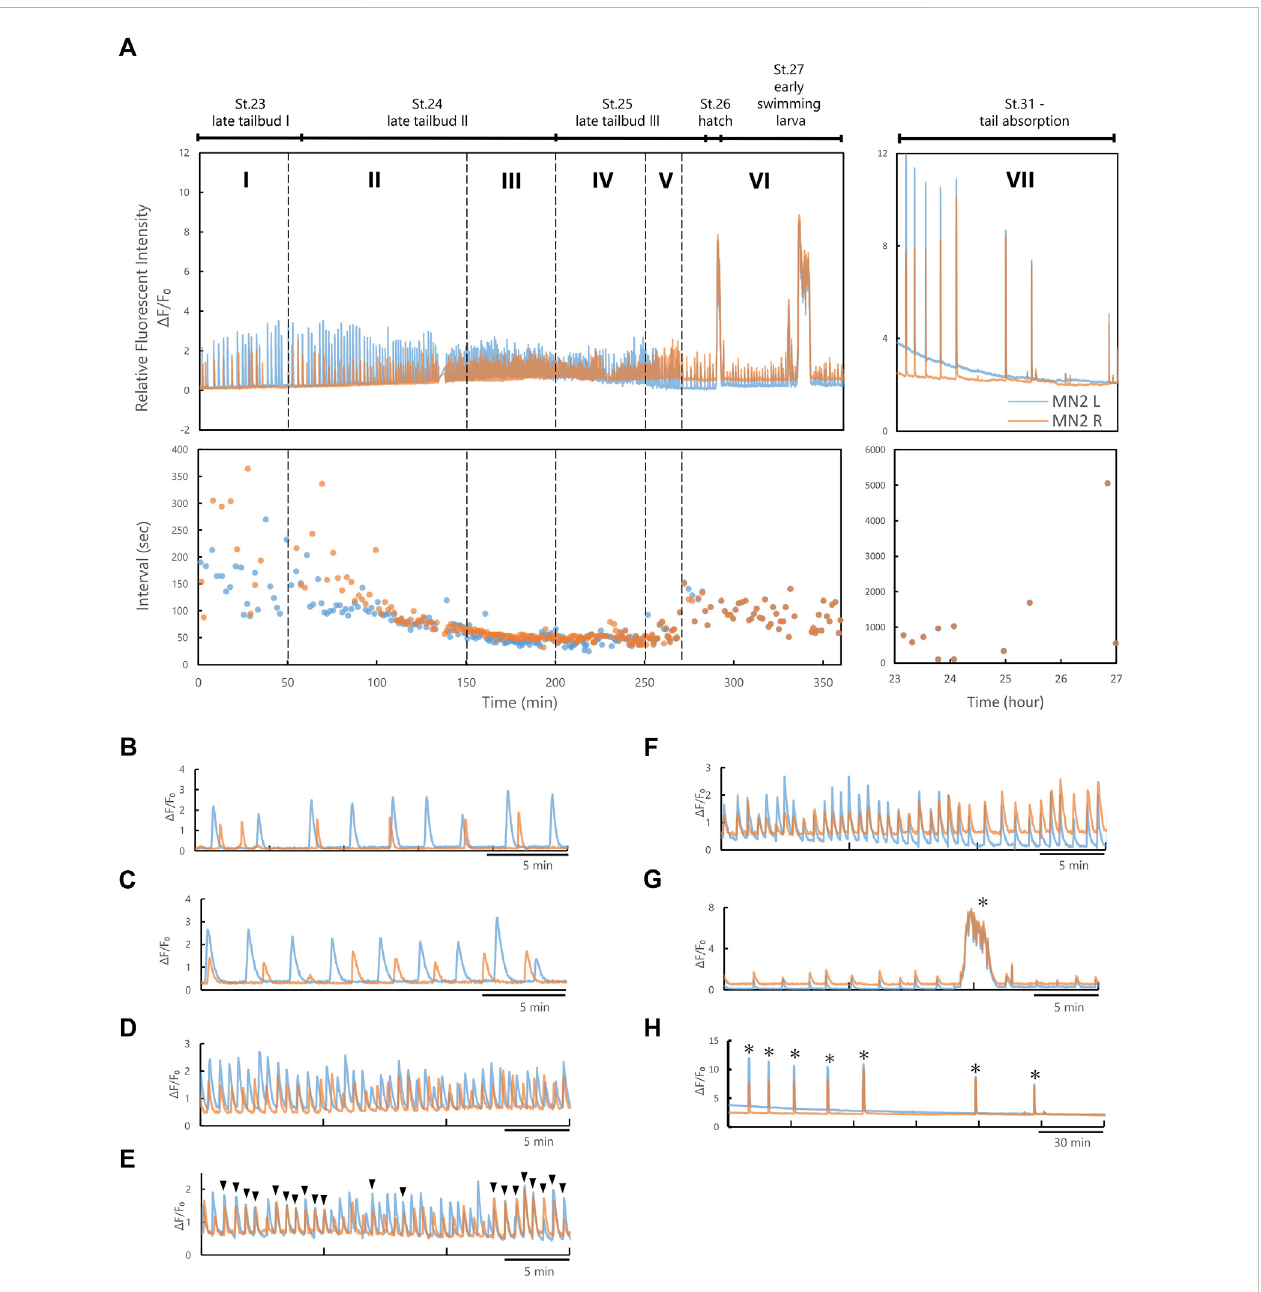
FIGURE 3 MN2LandMN2RCa 2+ transientscouldbedividedintosevenphasesbasedontheirsynchronicityandinter-burst-intervals. (A) AnexampleoftheRelative Fluorescent Intensity (RFI) and intervals of Ca 2+ transients observed with pSP-CiVAChT:GCaMP6s transduced larva (temperature, 0-9.5 hpf 22 ° C, during imaging 7.5 h 20 ° C). Blue, MN2L; orange, MN2R. (B) Phase I. (C) Phase Ⅱ . (D) Phase Ⅲ . (E) Phase IV. (F) Phase V. (G) Phase VI. (H) Phase VII. Black arrowheads represent the timing when the Ca 2+ peak of MN2L and MN2R synchronized, and asterisks represent Ca 2+